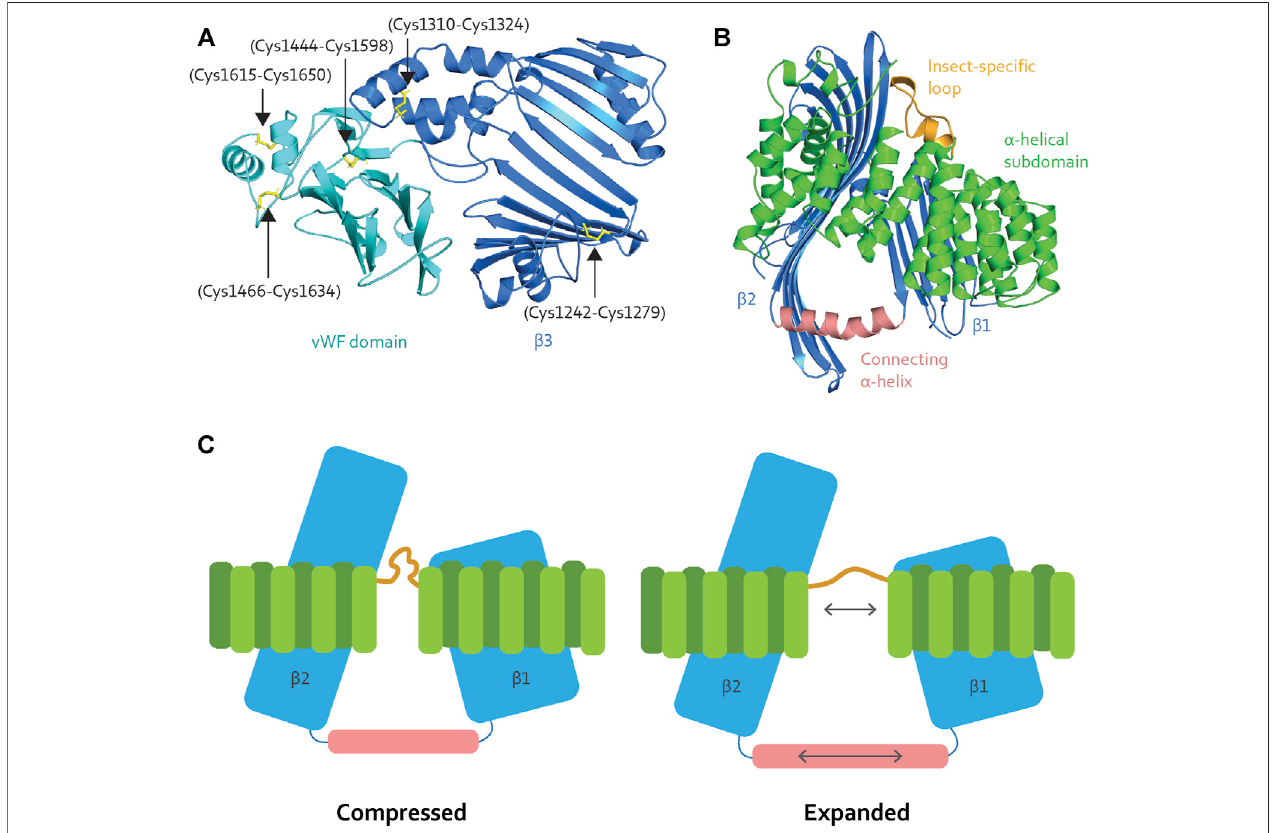
FIGURE 4 | (A) The β 3 (blue) contains two disul fi de bridges (black arrows), while the vWF domain (cyan) contains three (black arrows). The disul fi de bridges contribute stability to the binding site. (B) The α -helical subdomain (green) wraps around β 1 and β 2 (blue). The insect-speci fi c loop (orange) aligns with an opening between the β -sheets. β 1 and β 2 are connected through a long α -helix (light pink), creating a triangle-like shape of the cavity. (C) When Vg unloads lipid molecules, the lipid binding site is compressed. Vg requires elasticity to expand the lipid binding cavity during the loading and storage of many lipid molecules. We speculate that the insect-speci fi c loop (orange) and the long α -helix (light pink) add fl exibility, as illustrated here (double-pointed